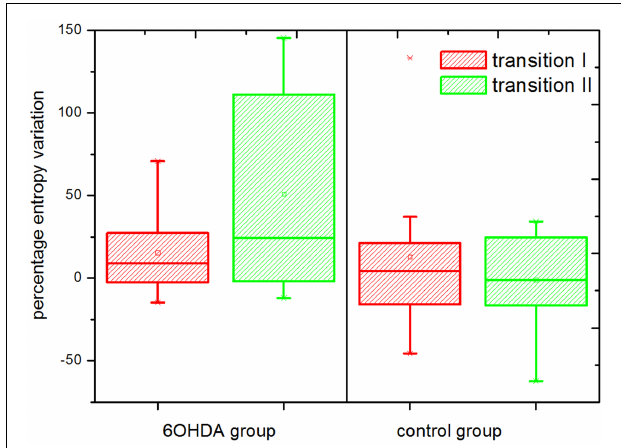
FIGURE 5 | Percentage entropy variation .Transition I and II indicate the percentage variation in the level of sample entropy during the transition from alertness level 1–2, and 2–3, respectively.The entropy variation during transition II was significantly higher in the parkinsonian (6OHDA) than in the control group ( p ≤ 0.05). A number of n = 2500 data points and an embedding dimension of five were used for the calculation of sample entropy.The boxes edges represent percentile 75 (p75) and percentile 25 (p25), respectively, the inner line indicates the median and whiskers account for p75 + 1.5 (p75–p25) and p25–p1.5 (p75–p25), respectively.The mean is represented by the inner, solid box. Crosses indicate